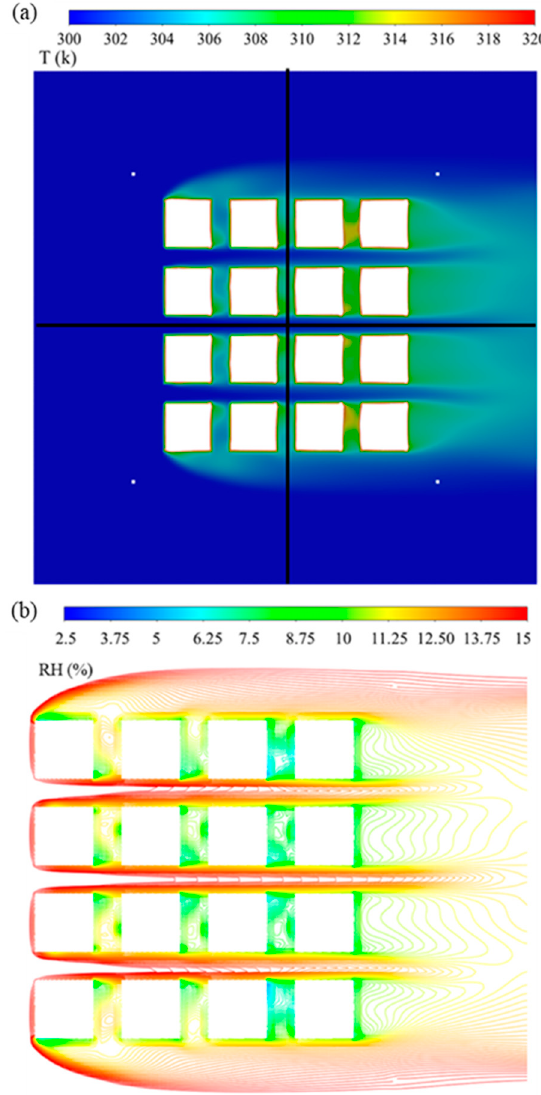
Figure 3. Contours of ( a ) temperature and ( b ) relative humidity are shown on the horizontal plane at the mid height of the coop for the simulation with an inlet velocity of 0.5 m/s, relative humidity of 15%, and the temperature of 300 k.